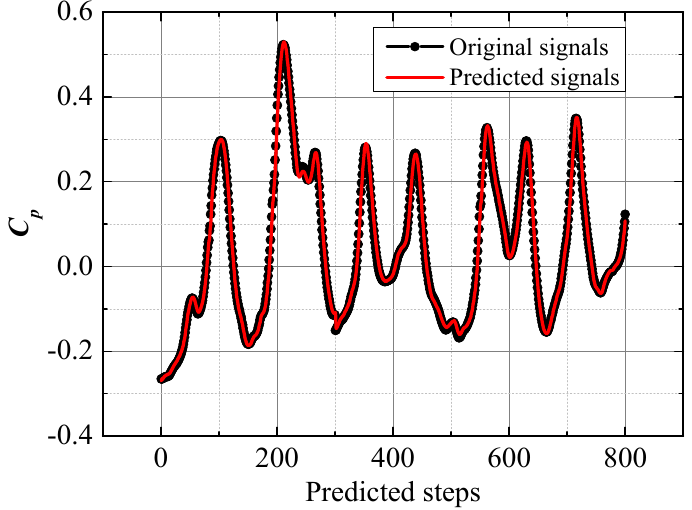
Figure 12. Predicting results of RBF-NNM.